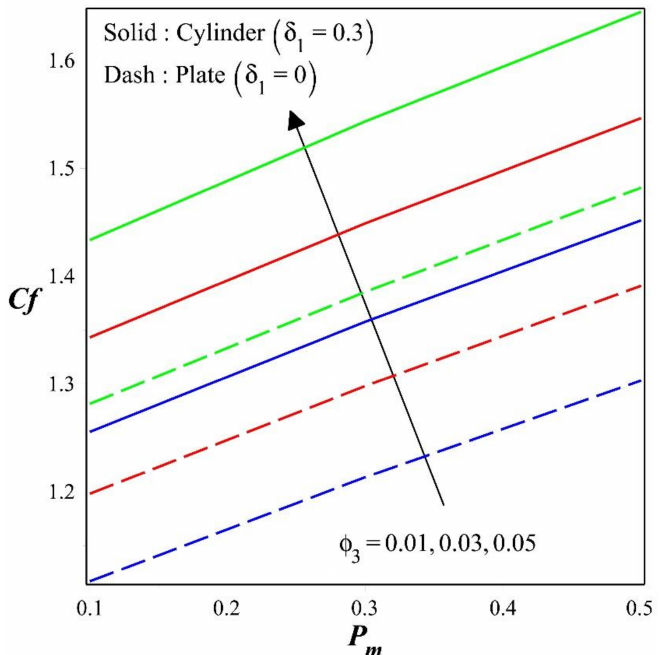
Figure 11. Variation of skin friction on porosity parameter for increment in solid volume fraction (keeping γ 1 = 0.1, ζ = 30 0 , φ 1 = φ 2 = 0.01 & H SS =